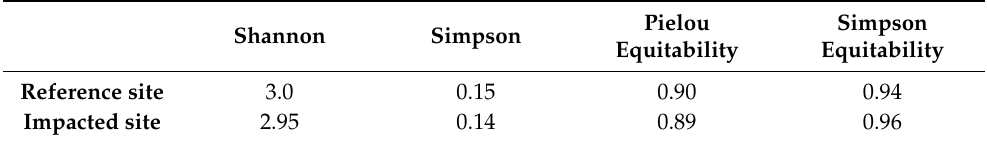
Table 9. Biodiversity metrics calculated from best classification maps on reference and impacted sites.